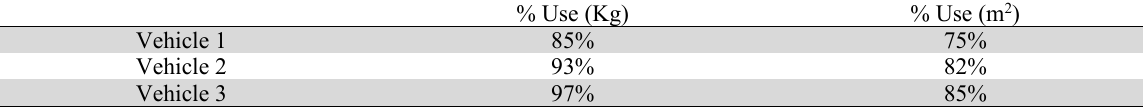
Percentage of use of the vehicles